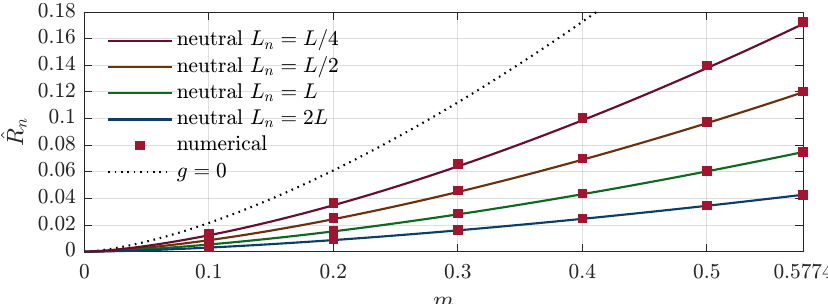
Figure 6. Numerical validation of normalized neutral-current-ripple RMS for L n = L /4, L n = L /2, L n = L , and L n = 2 L (i.e., g = 0.25, g = 0.5, g = 1, and g = 2). Normalization base V dc / ( 2 Lf sw ) .